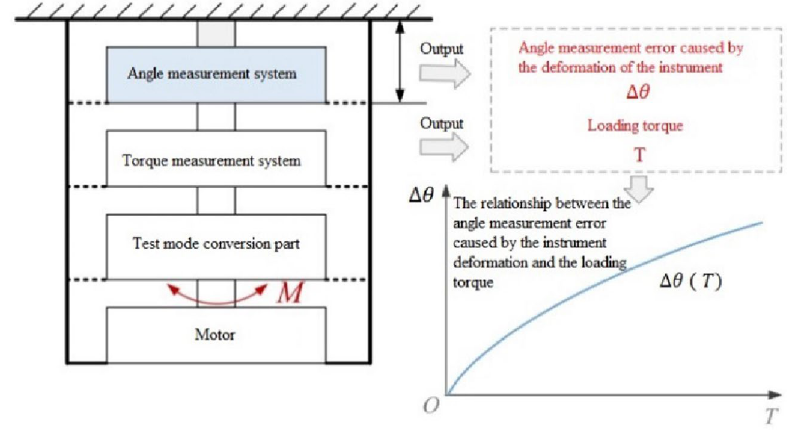
Figure 5. Measurement scheme for the angle measurement error caused by the instrument shaft deformation.